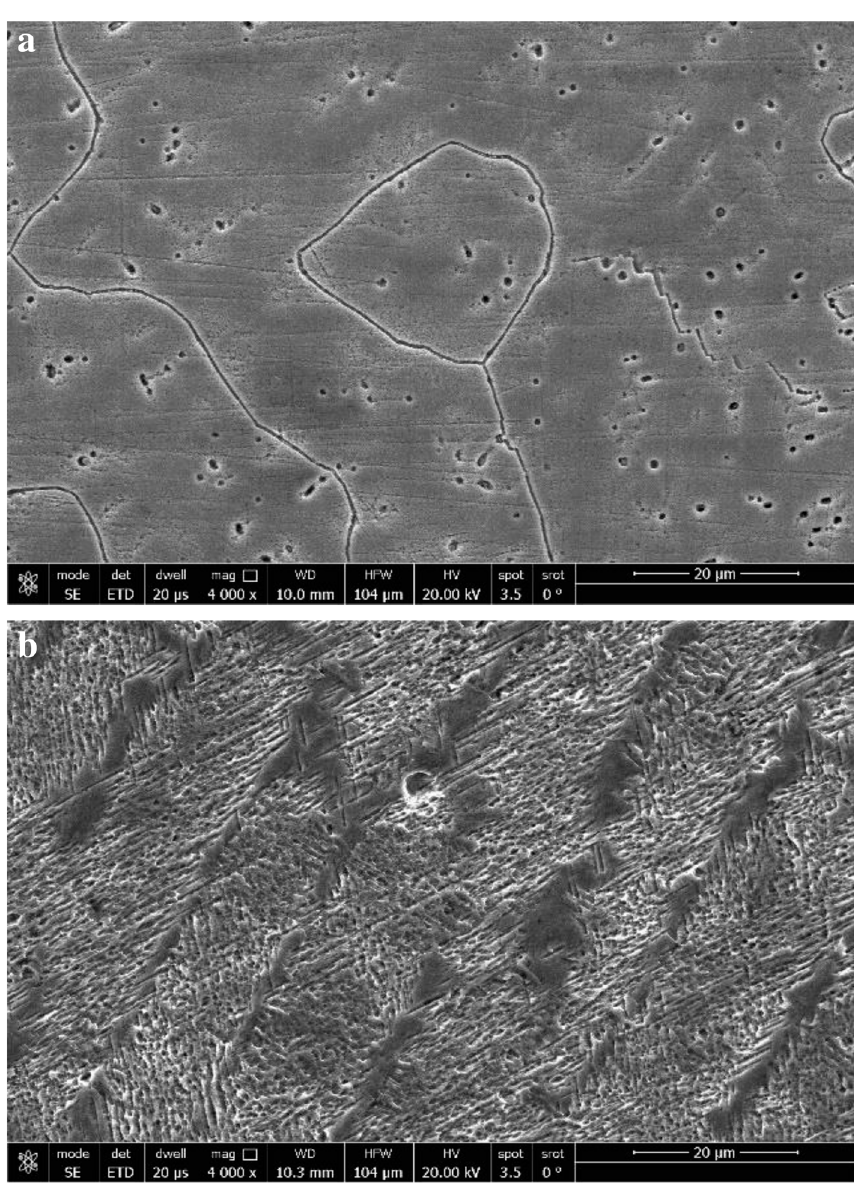
Fig. 26 SEM observations of single V and bevel welded joint using AWS A5.9 ER 307 filler metal. a The center of the weld metal with a single V groove with cooling. b Martensitic structure in the weld metal using single bevel groove with cooling at the